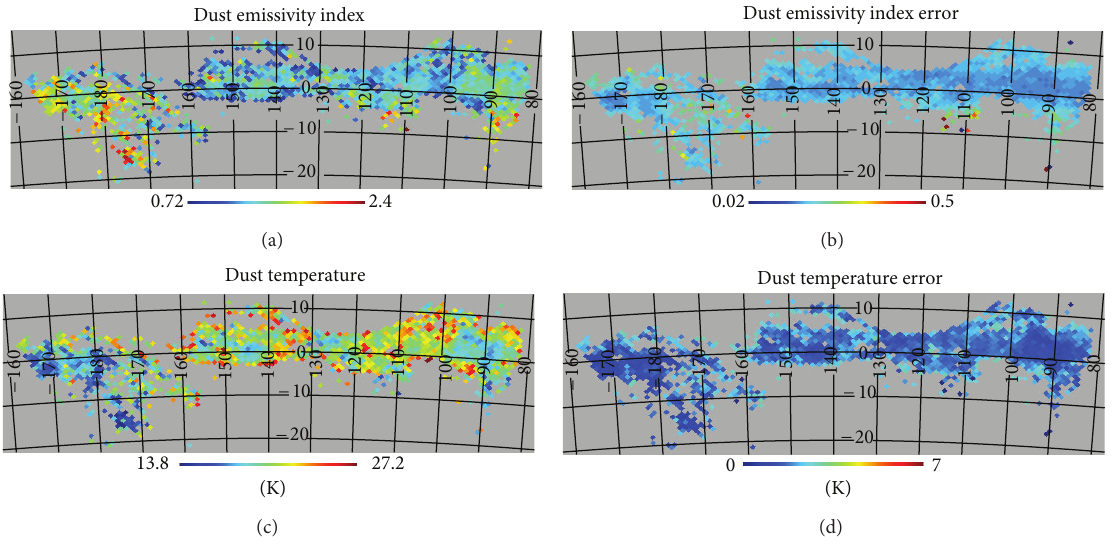
Figure 1: From top to bottom and from left to right: maps of the best-fit thermal dust emission spectral indices and temperature and uncertainties at 2𝜎 (95% C.L.) ( right